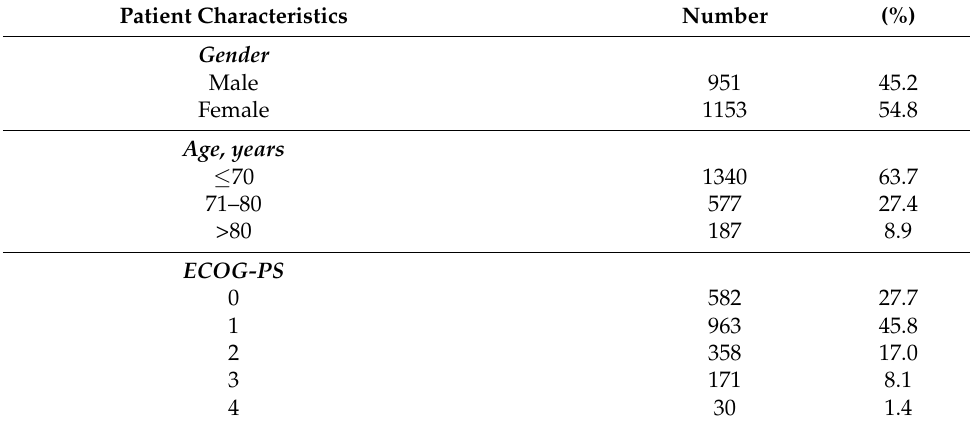
Table 1. Patient